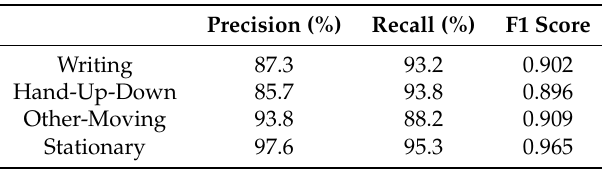
Table 2. Accuracy of the basic action